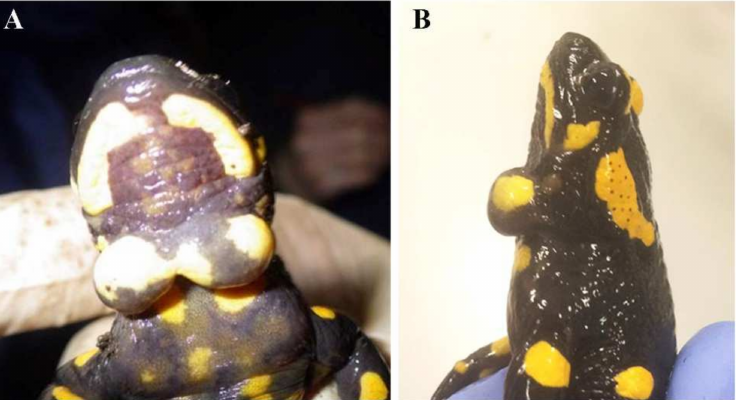
Figure 1. Salamander cysts. Ventral ( A ) and lateral ( B ) view of a male Salamandra salamandra with two turgid cysts occurring in a median position at the throat